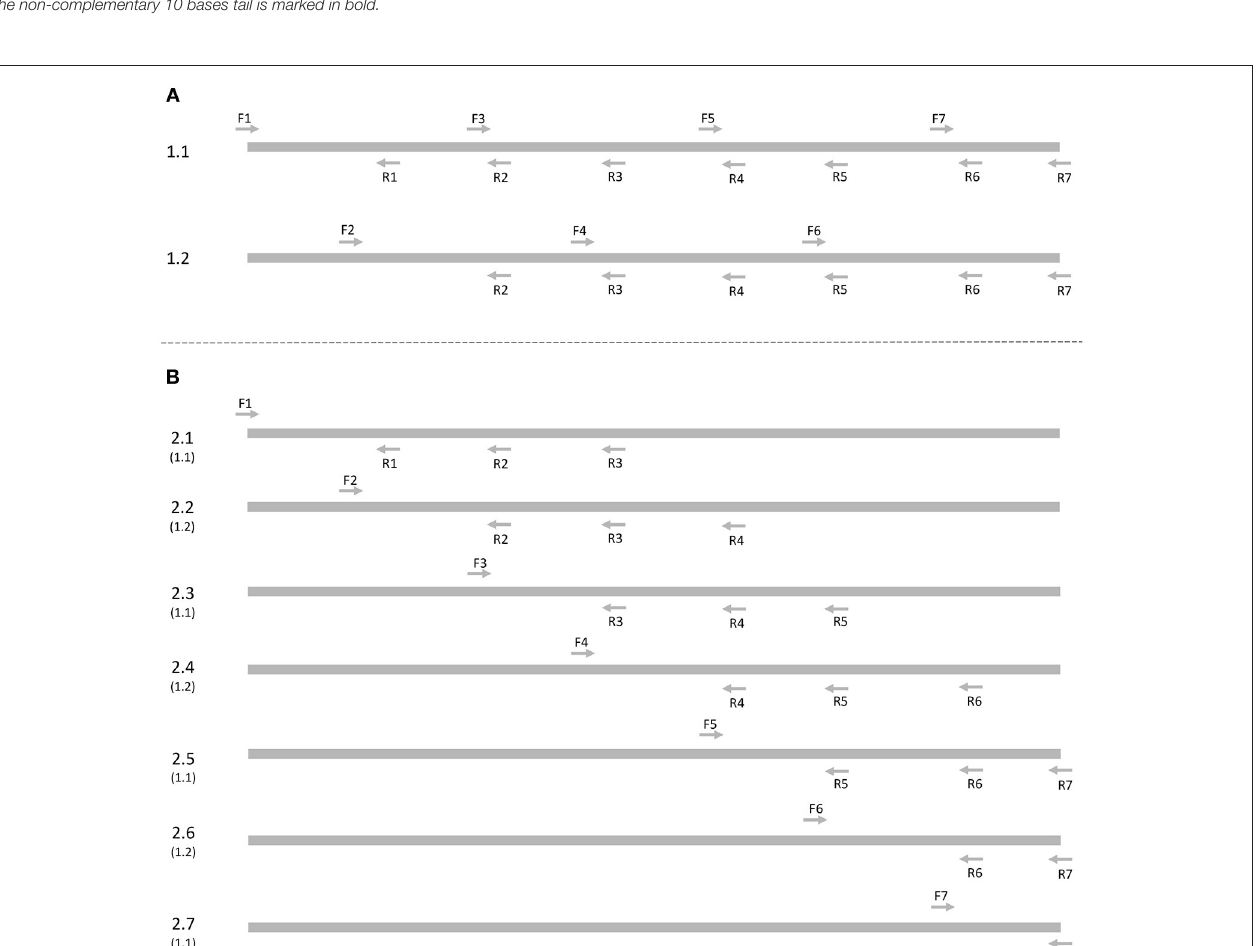
Frontiers in Ecology and Evolution |